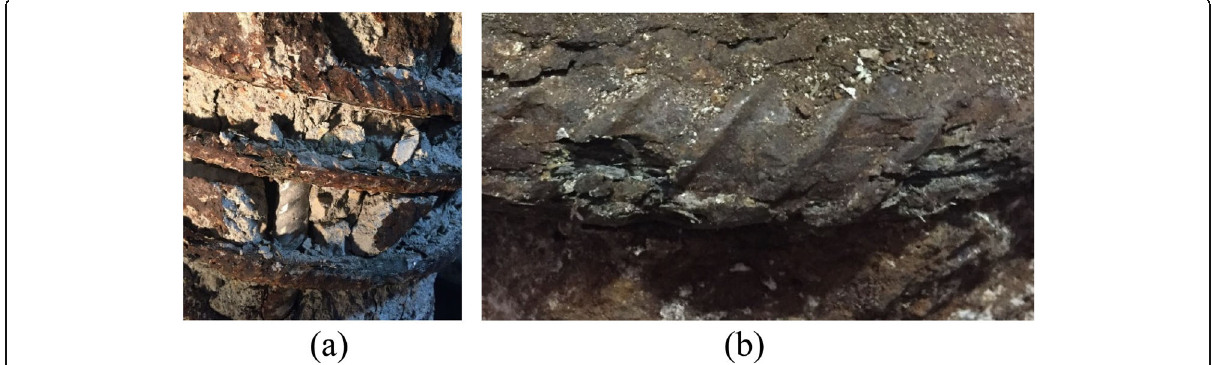
Fig. 6 Localized pitting on stainless steel spiral of specimen NN-R-2: a general view; b detailed view of single corrosion